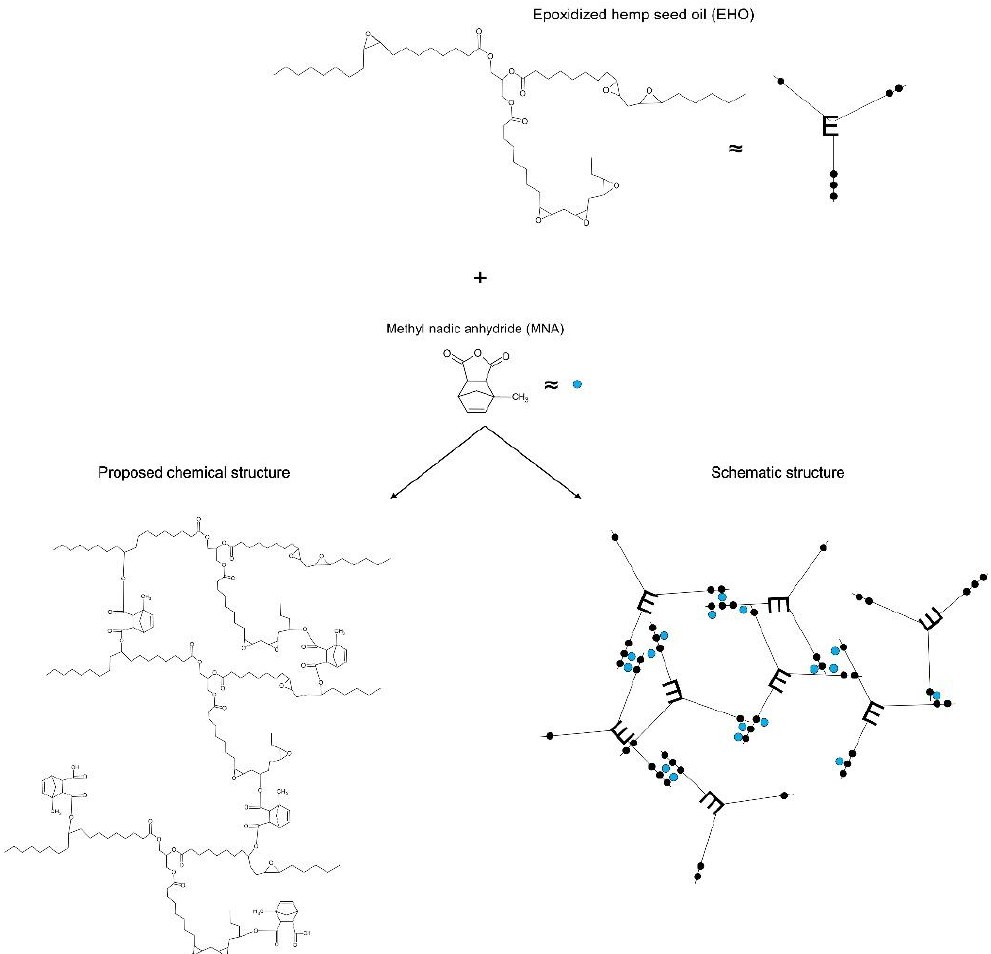
Figure 5. Epoxidized hemp oil (EHO) reaction using methyl nadic anhydride (MNA) as a crosslinker. Black dots: oxirane groups ; Blue dots : MNA molecule.